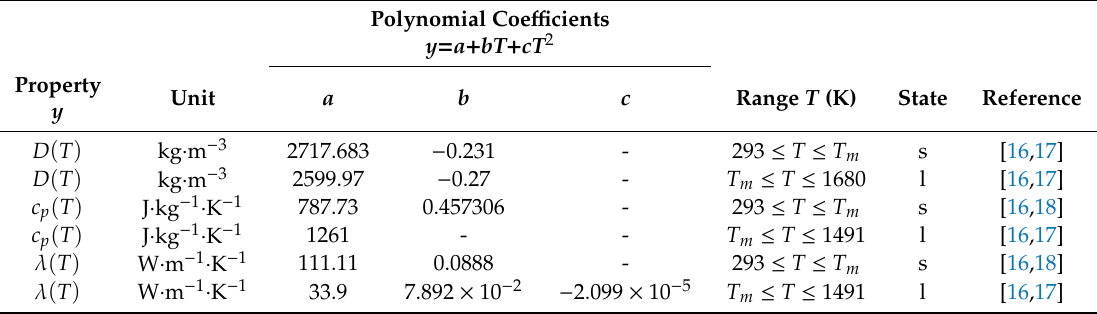
Table 3. Polynomial coe ffi cients vary with temperature T for calculation of Density D , Specific Heat